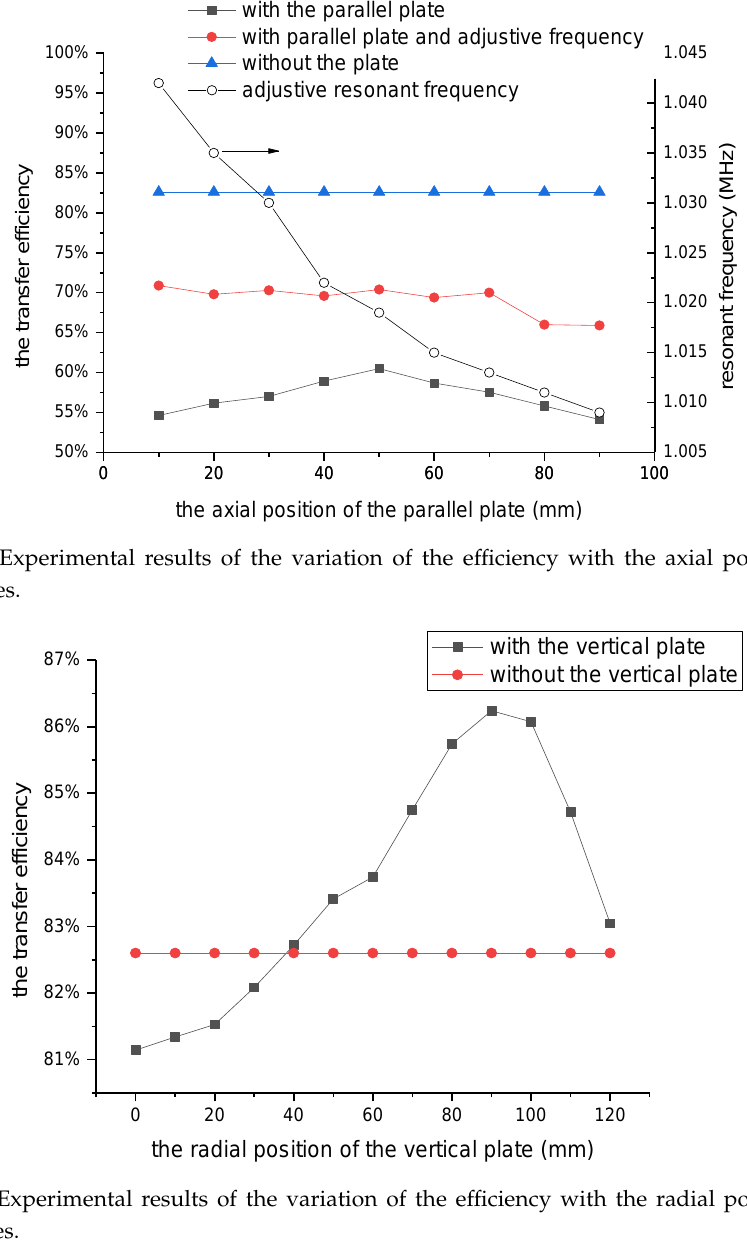
Figure 12. Experimental results of the variation of the efficiency with the radial position of the vertical plates.